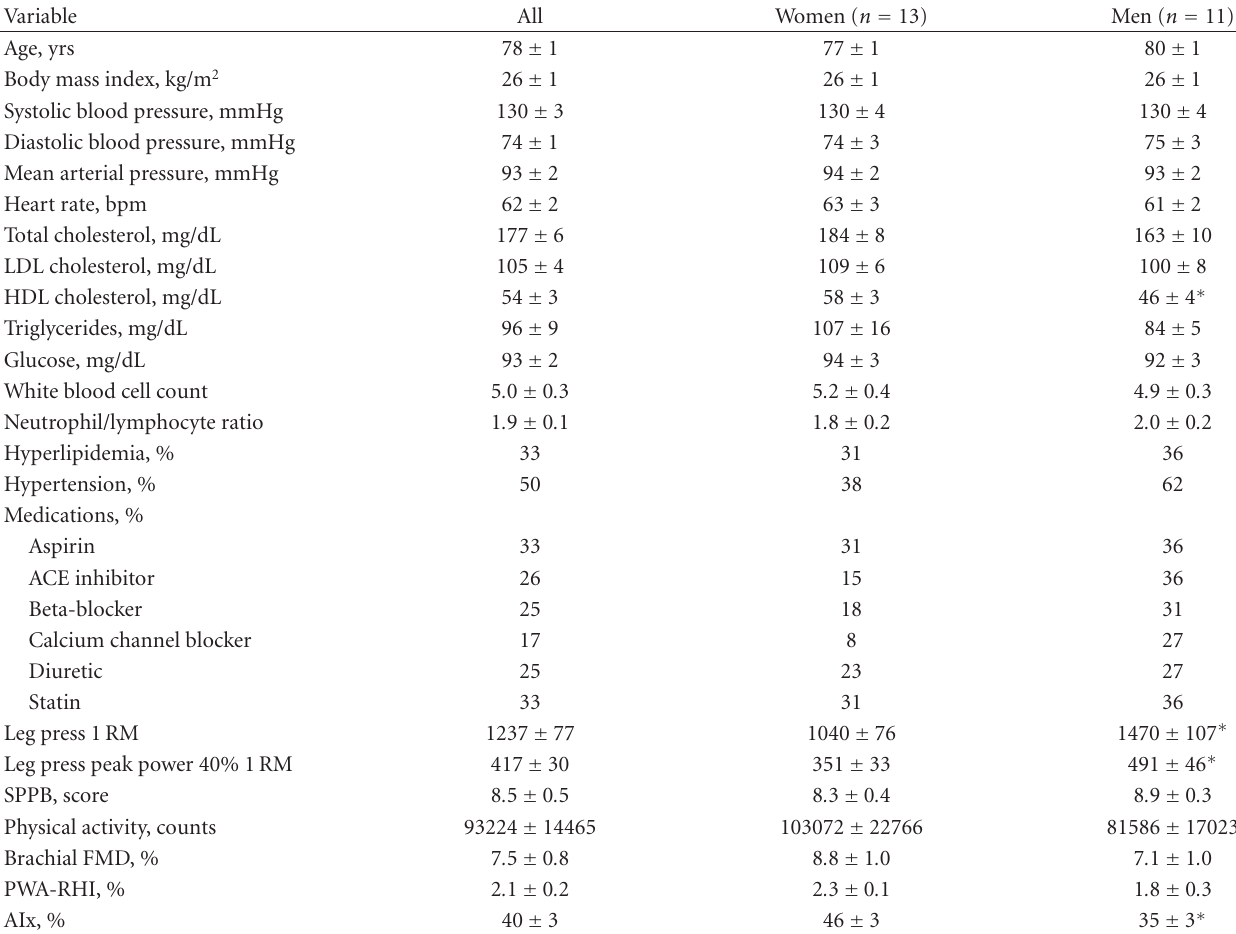
Table 1: Participant characteristics ( n = 24).